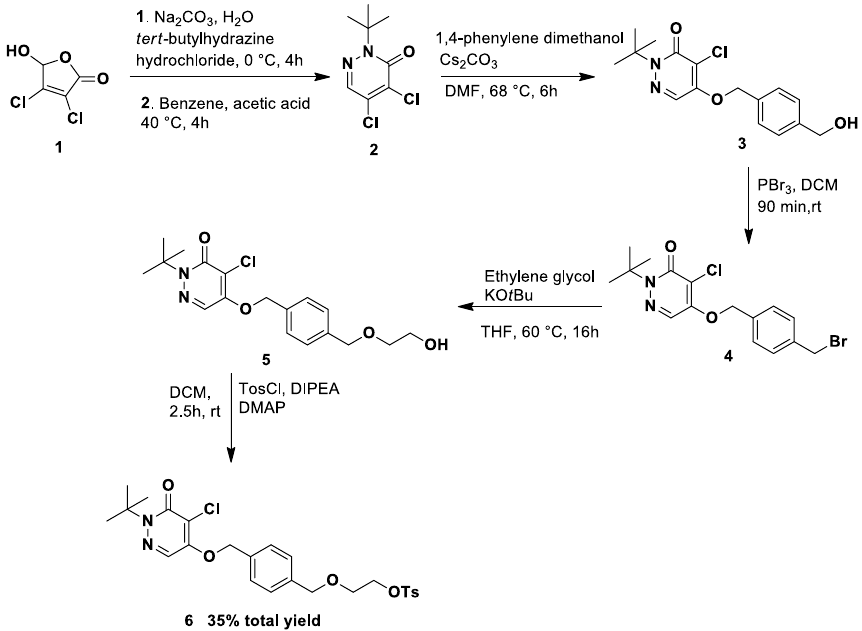
End of the synthesis, n =